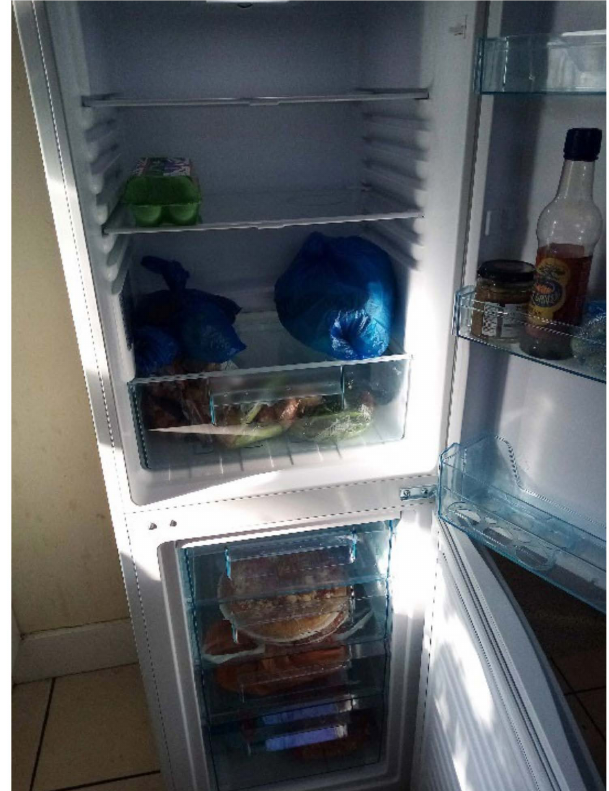
Figure 7. “Broken fridge”—Participant.Survey1.